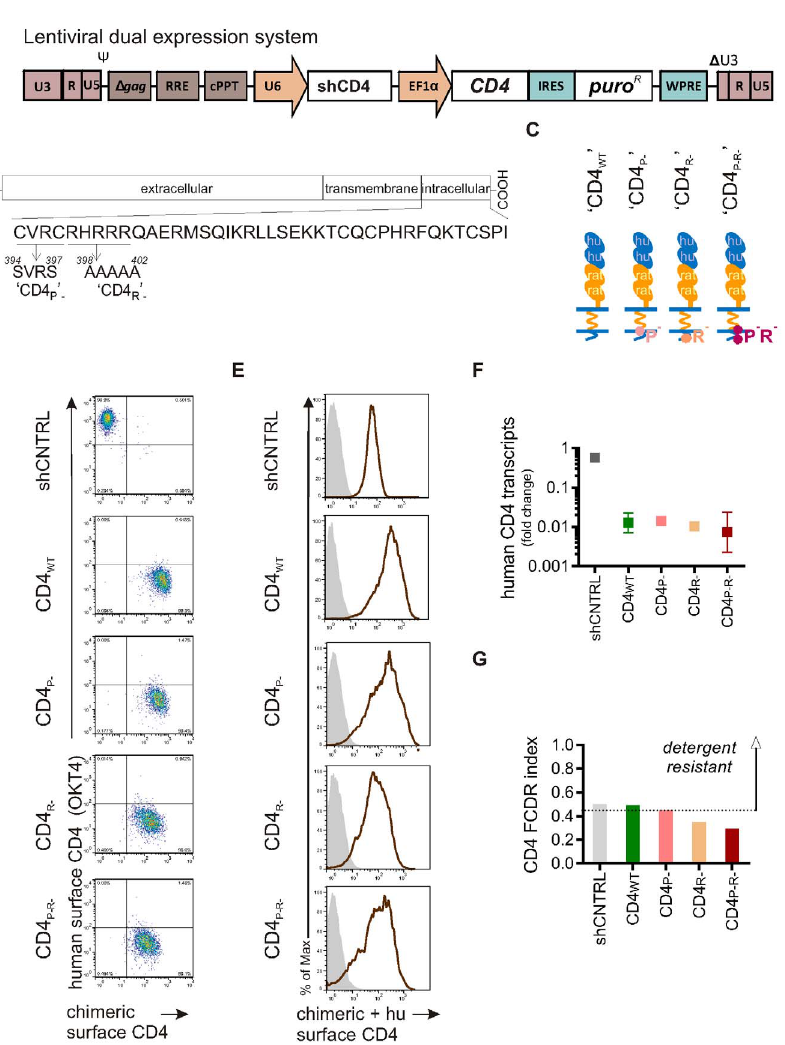
Figure 5. CD4 localization to detergent resistant membranes is reduced in CD4- mutants compared to wild-type CD4 in macrophages. A) Schematic diagram of self-inactivating dual-expression lentiviral vector used to knock-down endogenous CD4 and express puro R and chimeric CD4. B) Amino acid sequence of cytoplasmic tail of CD4 showing location of regions involved with DRM localization and the mutants inserted to produce CD4 P- , CD4 R- and CD4 P-R- . C) Symbols used to highlight the structure of each mutant chimeric CD4. Chimeric CD4 contains domain 1 + 2 and the cytoplasmic tail of human CD4 (depicted in blue), but domain 3 + 4 and transmembrane domain of rat CD4 (depicted in orange). D) Validation of the design of the lentiviral constructs expressing the chimeric CD4, TZM-bl cells were transduced with lentiviral vectors encoding shCD4 and wild-type (WT) or mutant versions of chimeric CD4 (P-, R-, or P-R-) or with a lentiviral vector expressing a control shRNA only (shCNTRL). Two-colour immunofluorescence (dot plot), showing the mean fluorescence intensities of mAb clones OKT4 and OX68, plotted on the Y-axis and X- axis, respectively. Gates were determined by using the two relevant isotype control antibodies. anti-CD4 mAb clone OKT4 recognises endogenous CD4 (domain 3 of human CD4) and anti-CD4 mAb clone OX68 recognises chimeric CD4 (domain 3 + 4 of rat CD4). E) Detection of surface expression of CD4 in PSC-macrophages. Histogram showing CD4 surface staining of PSC-macrophages with mAB clone 11830 (red/brown line) compared to the matched isotype control (shaded grey). anti-CD4 mAb clone 11830 recognises both endogenous human CD4 and chimeric CD4 (domain 1). F) Detection of CD4 transcripts. RNA was isolated from PSC-macrophages and analysed by RT-qPCR using specific primers. Symbols represent the relative mean number of copies of human endogenous CD4 mRNA relative to the control group (shown in Figure 4A) 6 SEM of technical replicates (n=3) using pooled RNA from three independent experiments. G) Detergent resistance of CD4. Bars reflect the mean Flow Cytometric Detergent Resistance (FCDR) index of CD4 in PSC-macrophages, calculated as described in materials and